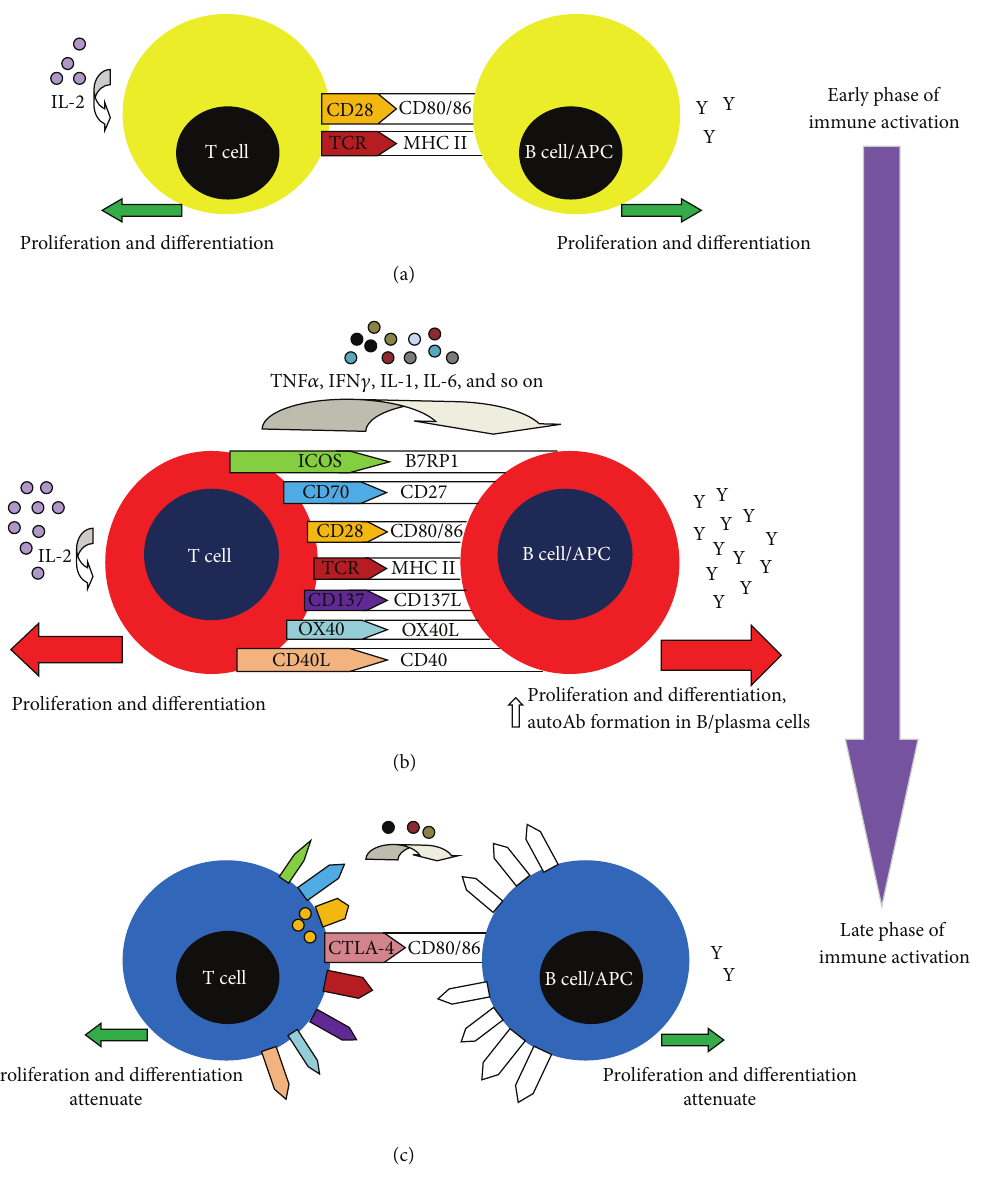
Figure 1: Expression of costimulation molecules in different stages of immune activation and their concerted effector functions. (a) Initial phaseofimmuneactivation;(b)maximalphaseofimmuneactivationwithexpressionofmanycostimulatorymolecules(figureisfordepiction only, costimulation molecules may not be all expressed in a single immune reaction), coupled with proliferation and differentiation of immunocytes, production of proinflammatory cytokines and autoantibodies; (c) after reaching the peak of activation, CTLA4 expressed on T cells interacts with CD80/86 on B cells/APCs with higher affinity than CD28. Immune response attenuates and costimulatory pathways start to disintegrate. CD28 molecules expressed during maximal activation phase are endocytosed, pictorially depicted as intracellular small round yellow vesicles in the T cells of condition (c). Abbreviations: TCR: T-cell receptor; MHC II: class II major histocompatibility complex; APC: antigen-presenting cells; and autoAb: